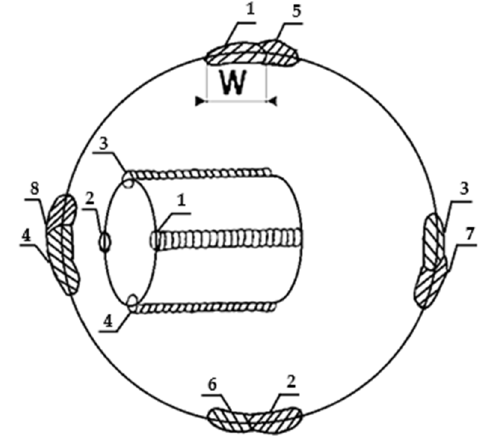
Figure 4. Laying sequence of the individual beads of the hardfacing coating (diagram). The numbers 1–4 in the internal diagram show the order in which the first stitches are laid on the damaged turbocharger shaft. The numbers 1–8 on the outer circle show the execution of the next stitches.